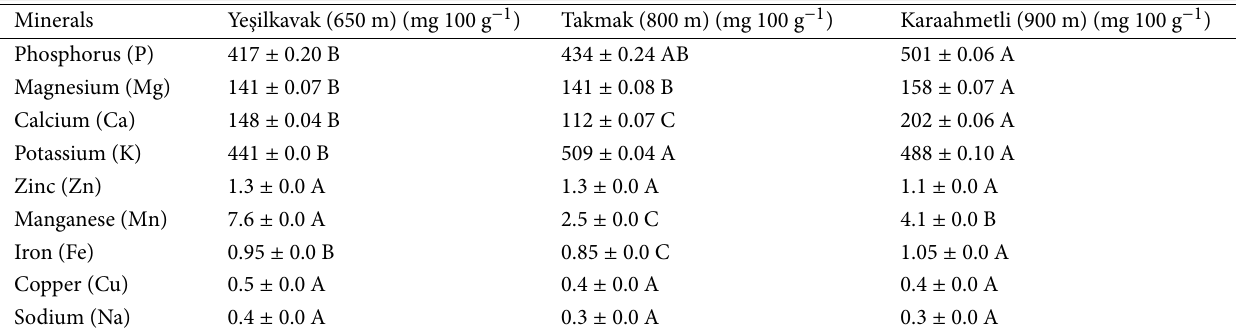
Table 3 Changes in some minerals of ‘Chandler’ walnuts according to growing altitude.